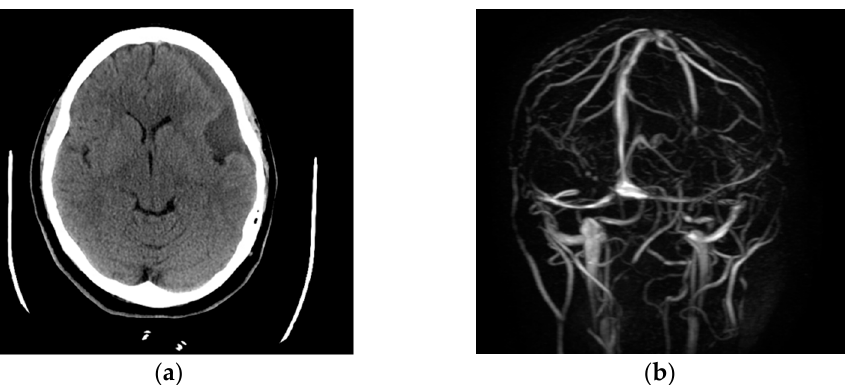
Figure A1. ( a ) (left) Axial CT (head showing left-sided subdural collection and mass effect on the adjacent cerebral cortex. ( b ) (right) MRA brain demonstrating the stenotic transverse sinus.